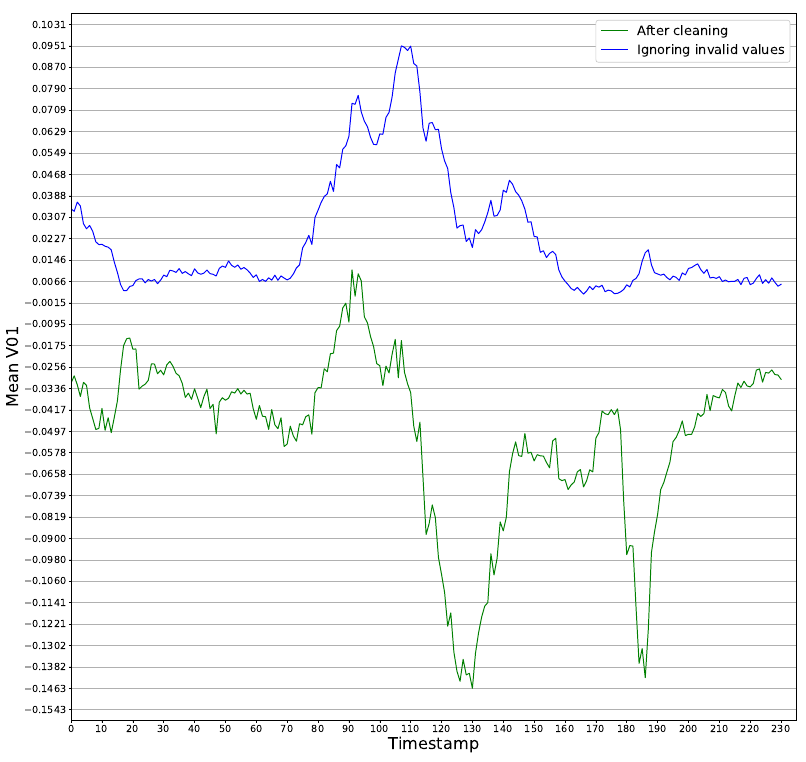
Figure 8. Time series plot for average V 01 values: ignoring invalid values and after